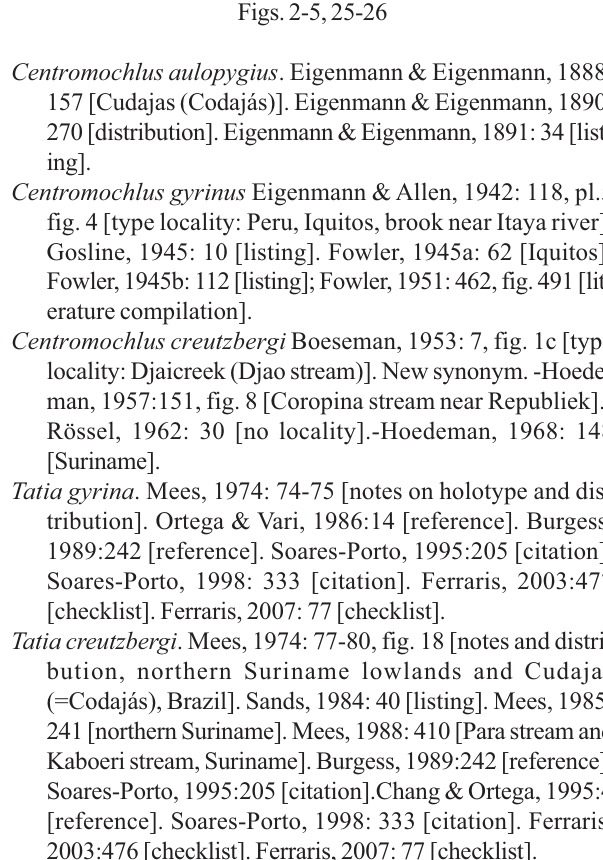
fig. 4 [type locality: Peru, Iquitos, brook near Itaya river].